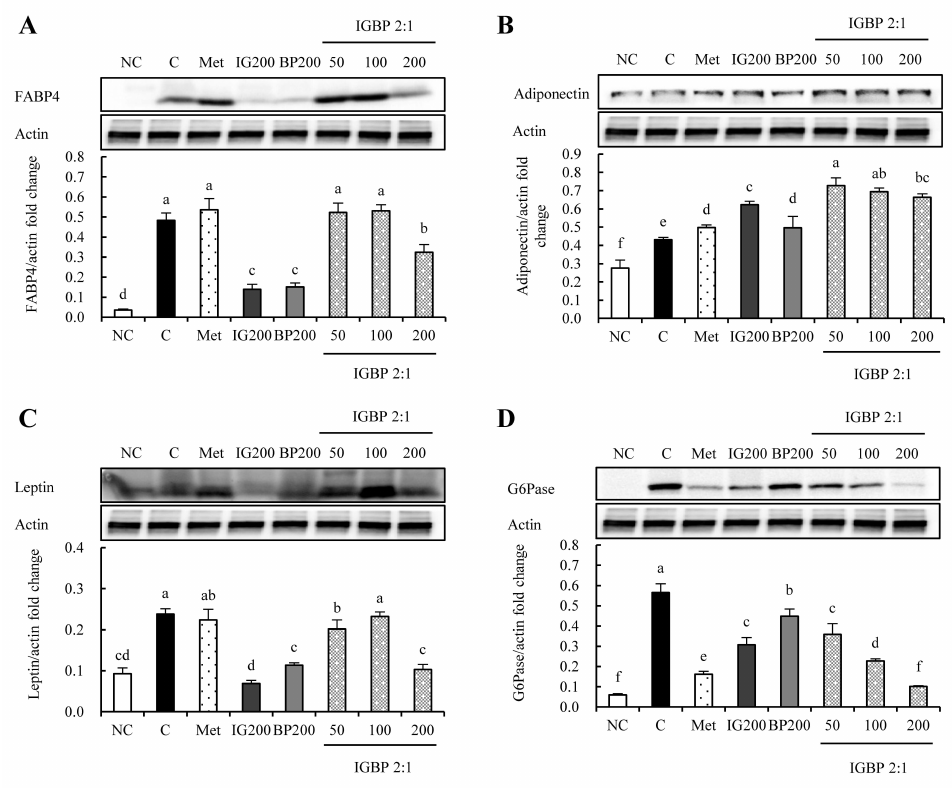
Figure 2. E ff ects of the IGBP 2:1 mixture on adipogenesis-related proteins in 3T3-L1 adipocytes: ( A ) FABP4 expression, ( B ) adiponectin expression, ( C ) leptin expression, ( D ) G6Pase expression. NC, normal control; C, di ff erentiated control; Met, metformin 1 mM; IG200, IG 200 µ g / mL; BP200, BP 200 µ g / mL; IGBP 2:1 (50, 100, or 200 µ g / mL). The resulting values are shown as mean ± standard deviation (SD; n = 3), and the di ff erent superscript letters (alphabet) indicate significance at p <